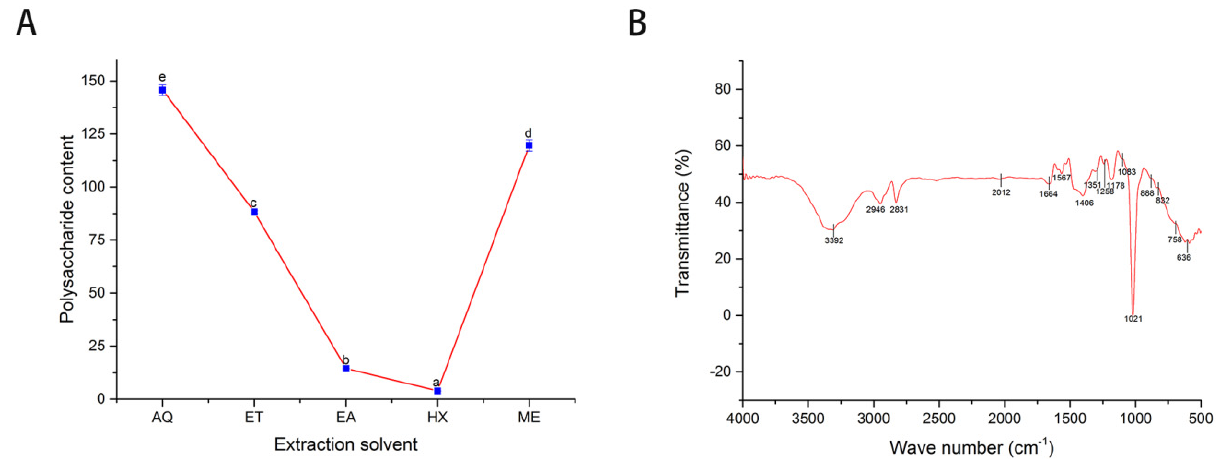
Figure 2. Polysaccharide contents (mg GE/g DW) of the various solvents ( A ) and FT-IR spectroscopy analysis of methanol extracts, showing characteristics peaks corresponding to the functional group of the constituents ( B ). GE: Glucose equivalent; AQ: Water; ET: Ethanol; EA: Ethyl acetate, HX: n-Hexane; ME: Methanol. The different letters in A indicate statistical differences ( p < 0.05).